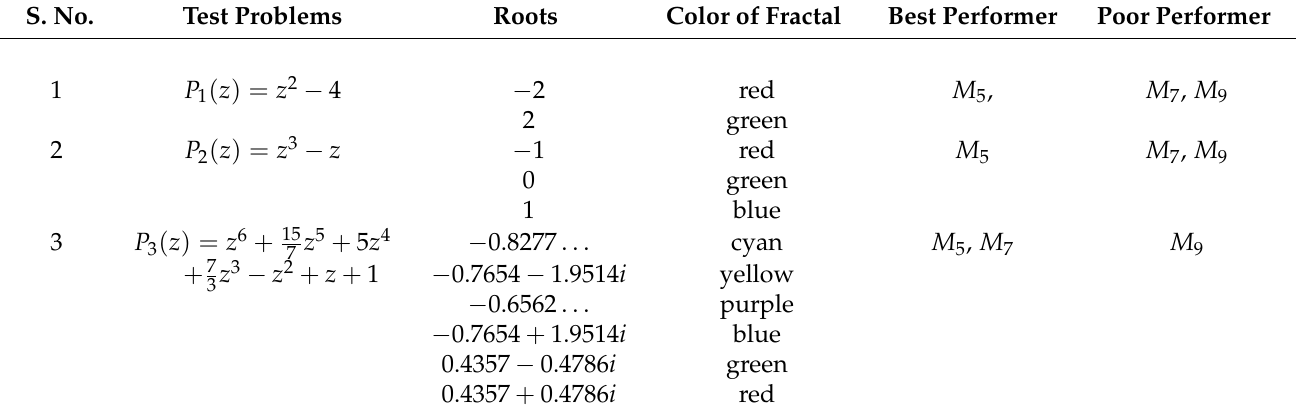
Table 4. Comparison of performance based on basins of attraction of methods. S.